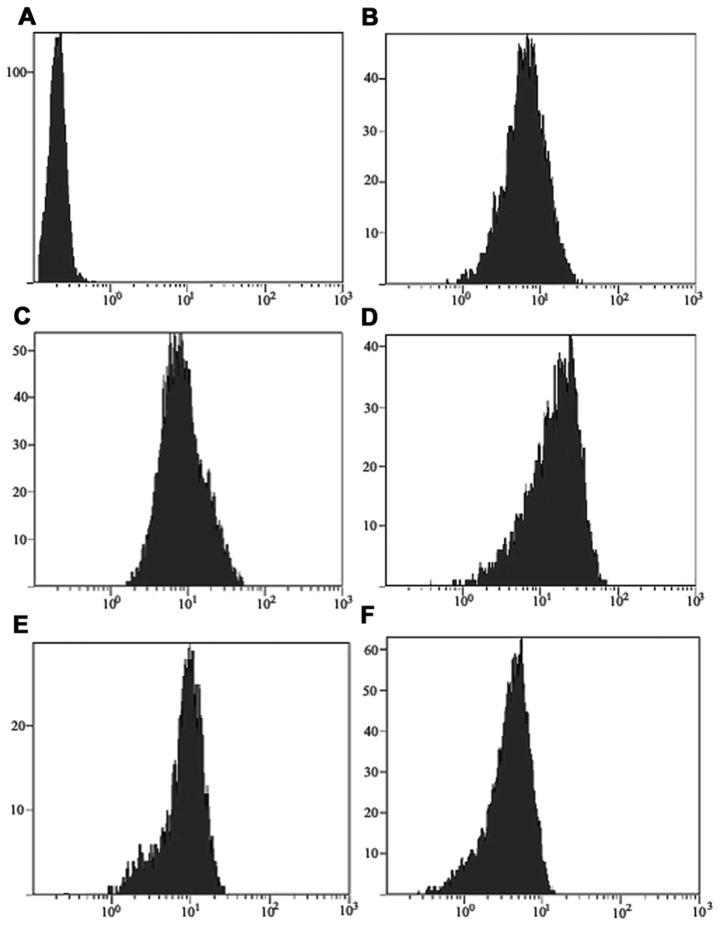
Analysis of polylactosamine chains by flow cytometry. The expression of polylactosamine was recognized by LEL, which was replaced by phosphate-buffered saline (PBS) and used as a control. The intensity of LEL staining was shown as the X-Mean. In the groups (A) control; (B) NC; (C) Mock; (D) T8S; (E) T8Scr; and (F) T8Si, the X-Mean was 0.03±0.02, 7.08±0.14, 7.57±0.05, 17.61±0.21, 7.83±0.17 and 4.45±0.09, respectively.